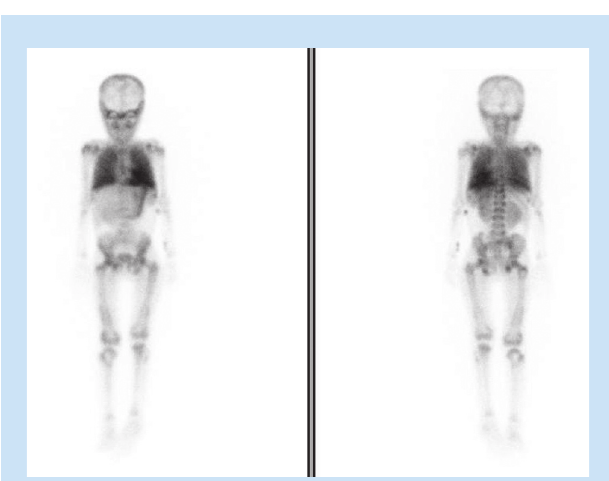
Fig. 3a. Tc-99m MDP whole body scan demonstrating diffuse visceral calcification in the lungs, myocardium and stomach, with no well-defined osteoblastic metastases noted.